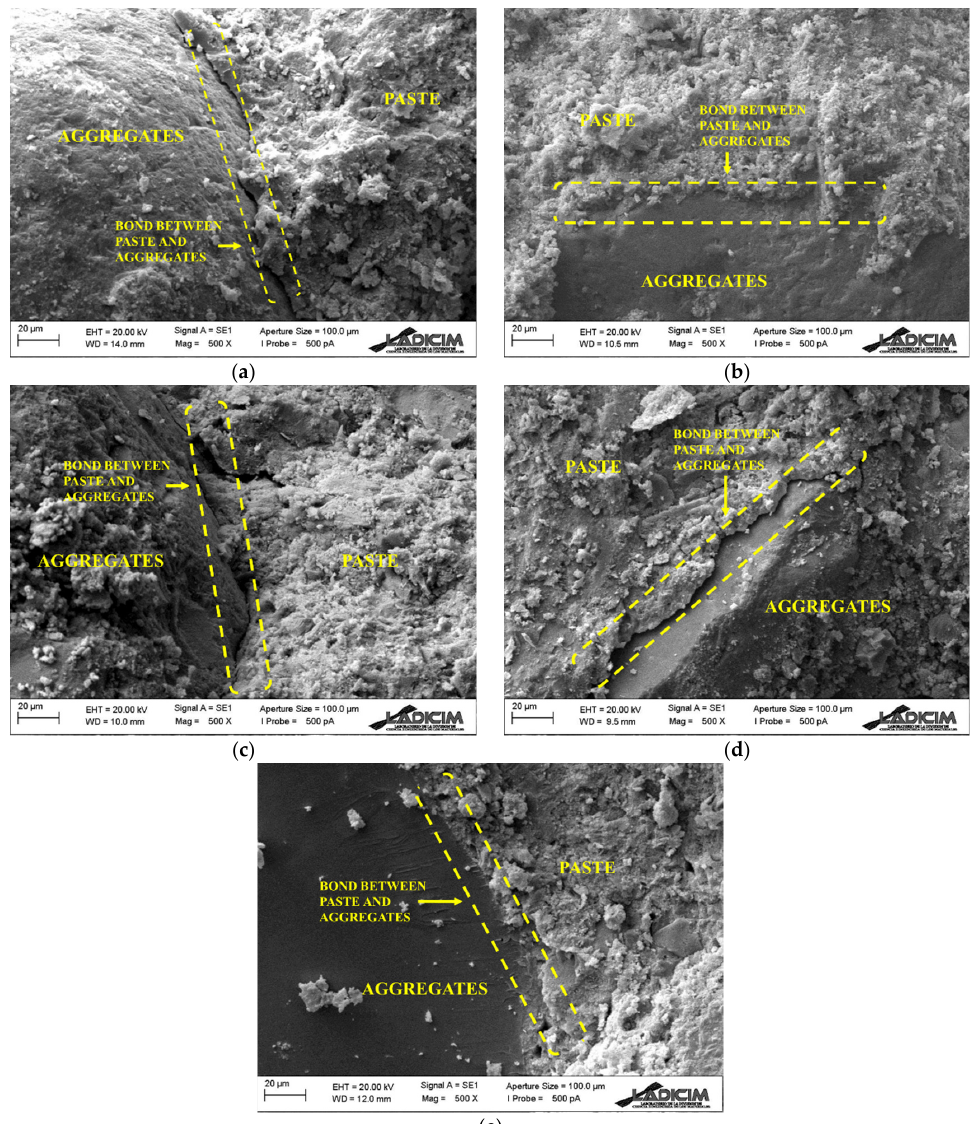
Figure 22. Microstructural analysis under 500× magnification: bond between paste and aggregates of UFS mortars with 0% ( a ), 25% ( b ), 50% ( c ), 75% ( d ) and 100% ( e ) substitution.